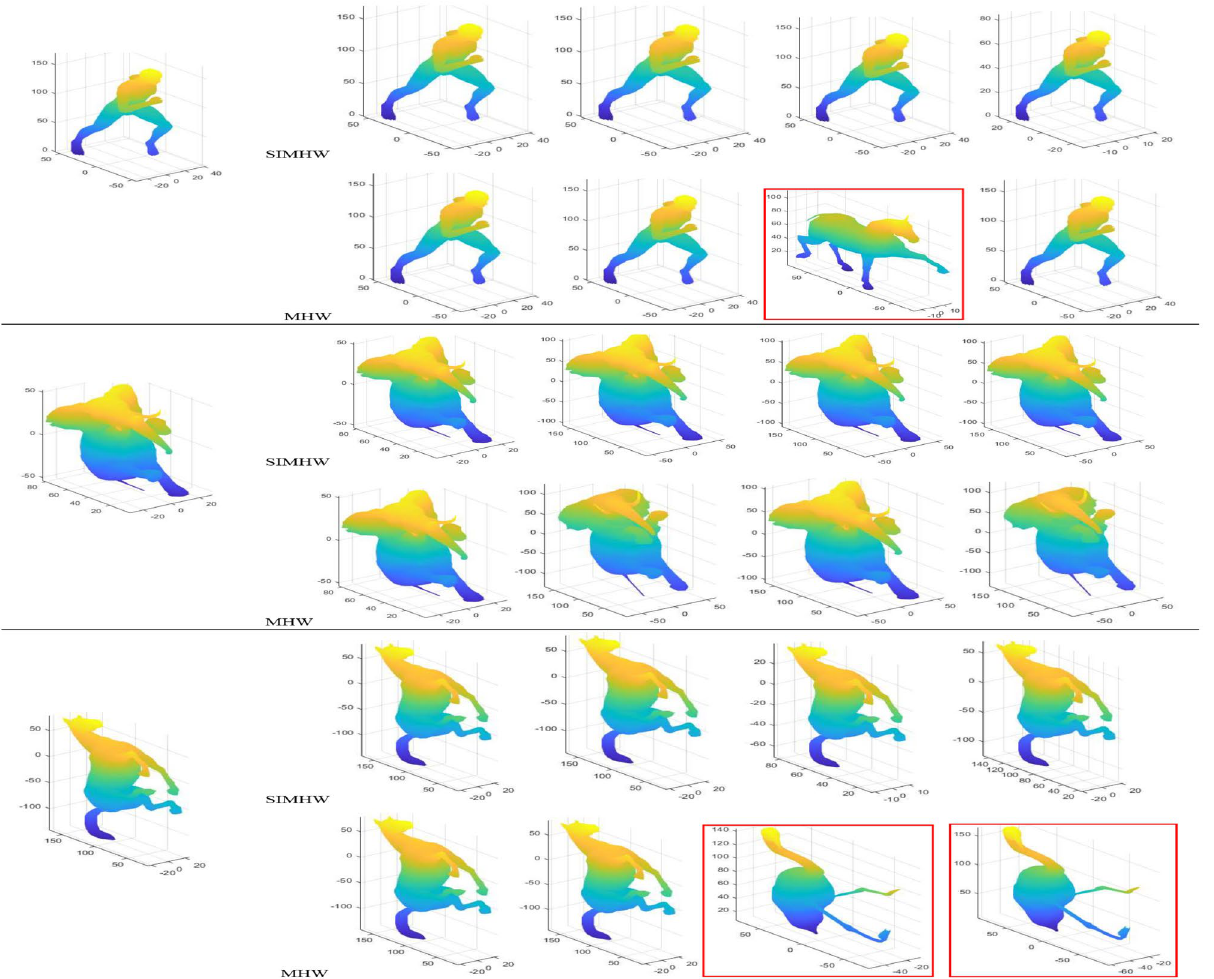
Figure 9. Shape retrieval results (SHREC2010). Left: queries; right: first matches using SIMHW and